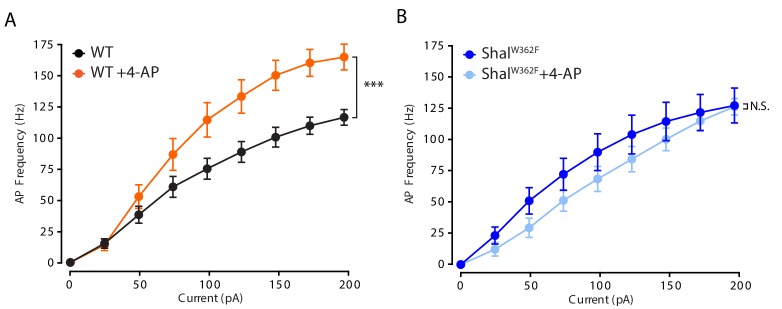
4-AP Does Not Increase Firing Rates in ShalW362F Motoneurons.(A) F-I curves of WT (black, n = 9) and WT +4 AP (orange, n = 9). (B) F-I curves of ShalW362F (dark blue, n = 5) and ShalW362F +4-AP (light blue, n = 9). Mean ± S.E.M.; two-way RM-ANOVA and Bonferroni's multiple comparisons test.